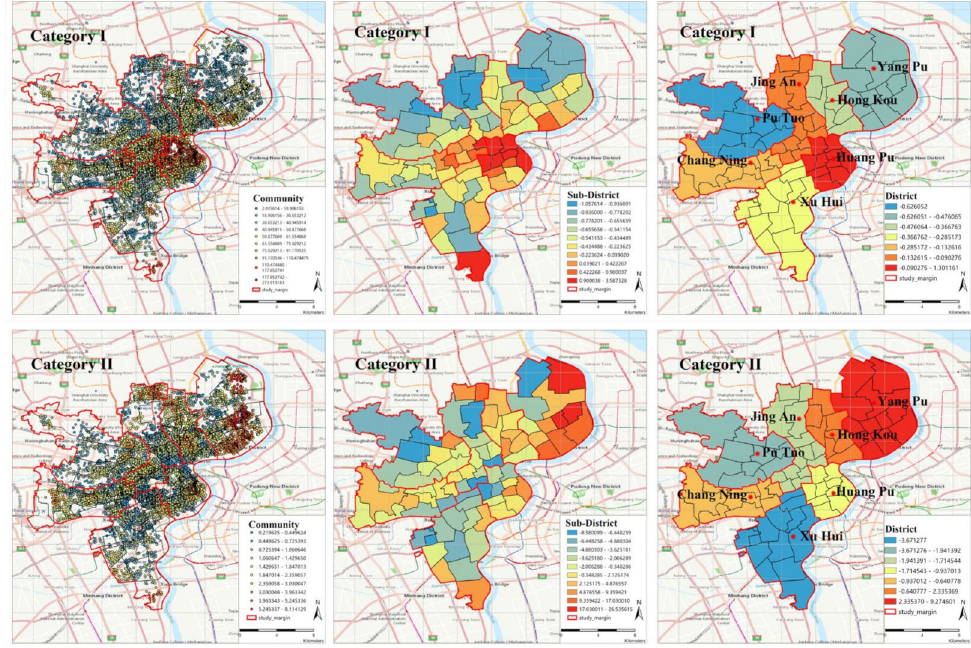
Figure 5. Statistical analysis of administrative regions (community, sub-district, and district).